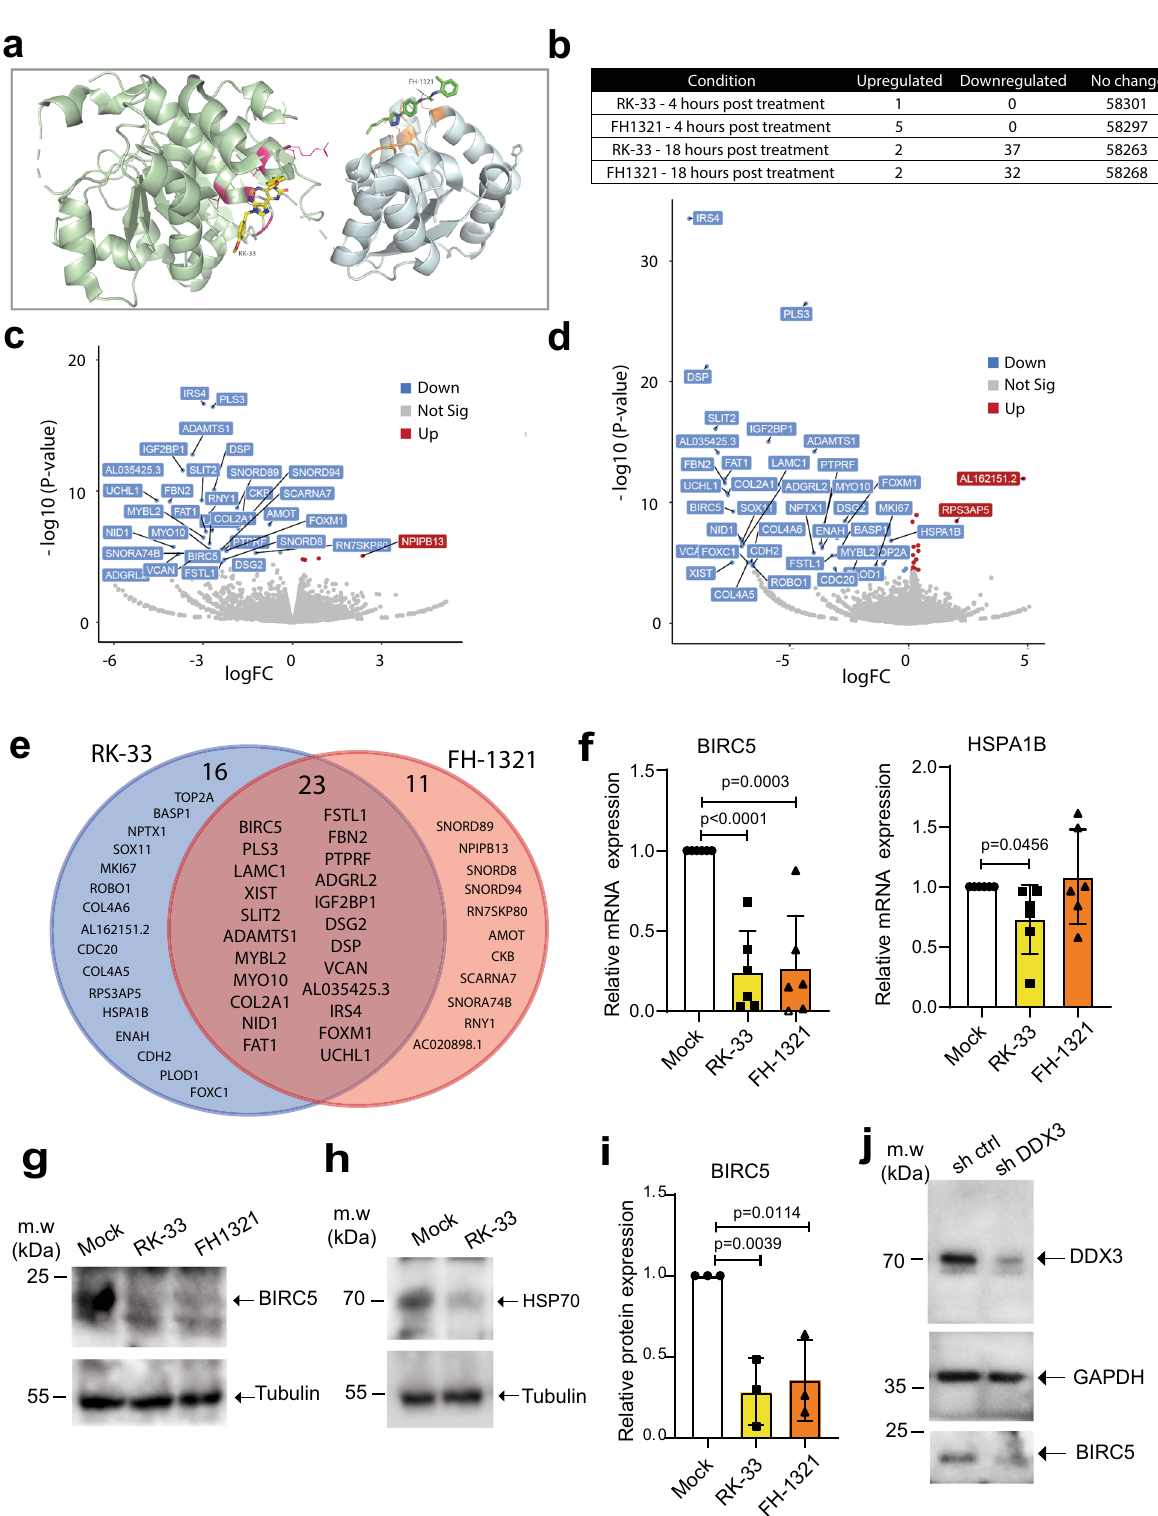
CD4 + T or CD8 + T cells (Supplementary Fig. 4c – f) as deter- mined after induction/stimulation with CD3/CD28. We also con fi rmed that DDX3 inhibition at the concentrations used does not affect de novo host cell translation in primary CD4 + T cells (Supplementary Fig. 4g, h). Finally, we determined if treatment of CD4 + T cells with DDX3 inhibitors could induce an upregula- tion of NF- κ B target genes by RT-qPCR. Treatment with RK-33